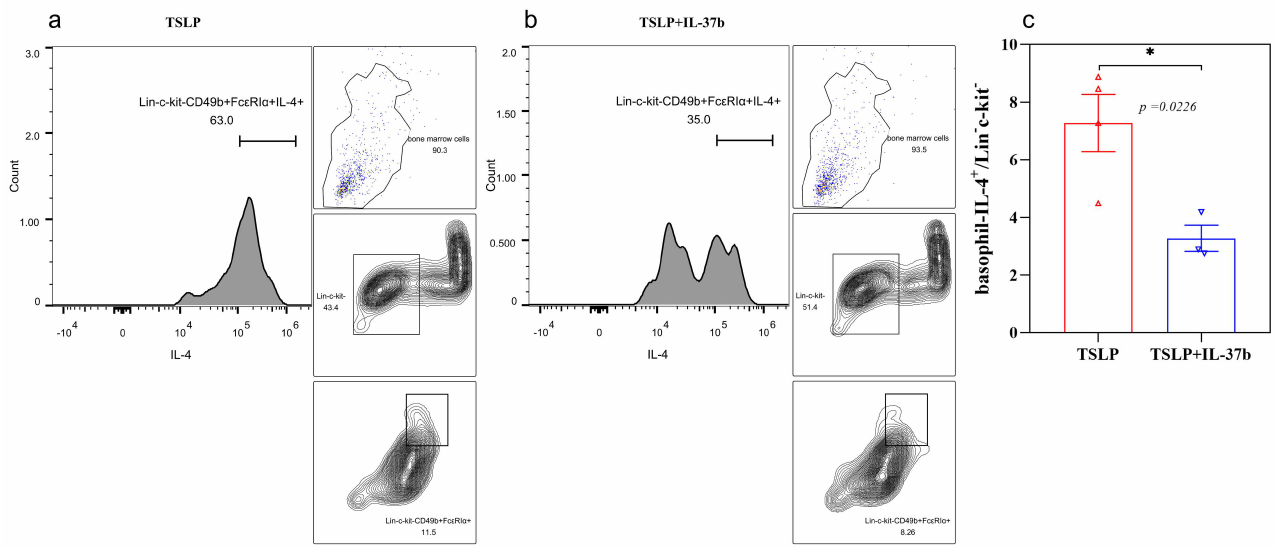
Figure 5. Effects of IL-37b on the IL-4 release from basophils induced by TSLP. ( a , b ) Flow cytometric analysis of IL-4-positive basophils in bone marrow cells; ( c ) quantitative analysis of IL-4-positive basophils in bone marrow cells. Bar charts are shown as mean ± SEM of n = 3 or 4. * p < 0.05 when compared between the